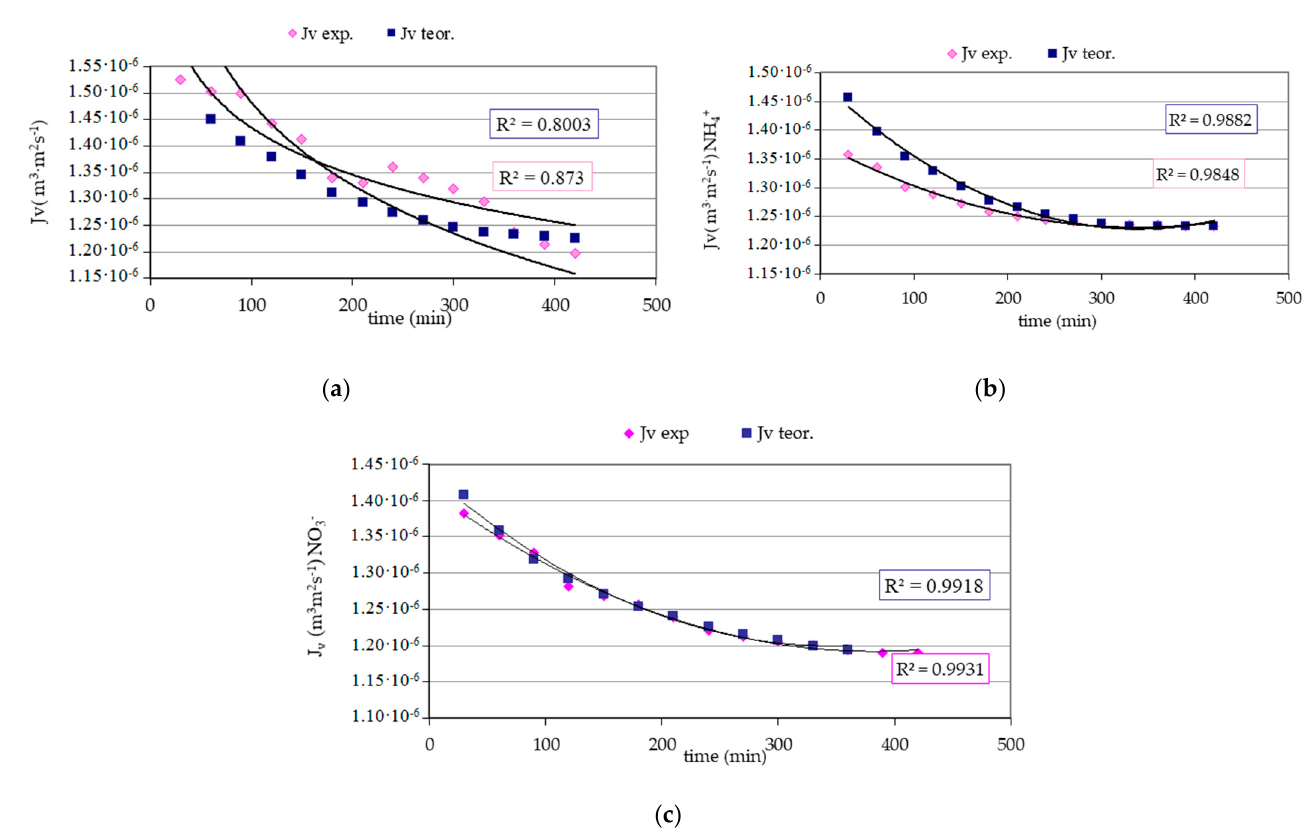
Figure 4. The dependence of the experimental and theoretical volumetric flux (calculated with the reversible resistance model) on time for: ( a ) infiltration water, ( b ) infiltration water with NH 4+ , ( c ) infiltration water with NO 3– , where: J v expe − J v experimental, J v theor − J v theoretical.